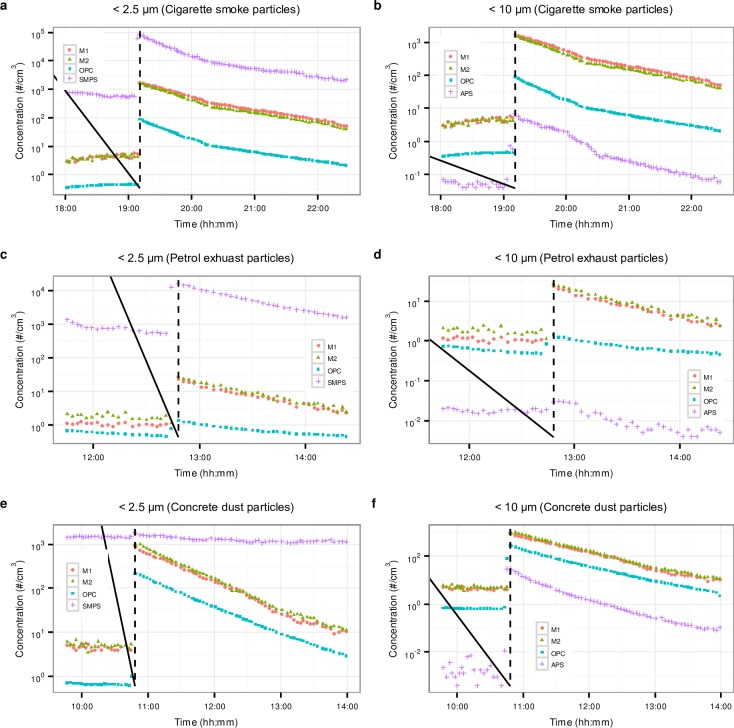
Time series of particles number concentrations measured during the chamber experiments.a) Cigarette smoke particles in the size fraction: M1 ≤ 2.5 μm, M2 ≤ 2.5 μm, OPC ≤ 2.1 μm and SMPS = total PNC. b) Cigarette smoke particles in the size fraction: M1 ≤ 10 μm, M2 ≤ 10, OPC ≤ 7 μm and APS = total PNC. c) Petrol exhaust particles in the size fraction: M1 ≤ 2.5 μm, M2 ≤ 2.5 μm, OPC ≤ 2.1 μm and SMPS = total PNC. d) Petrol exhaust particles in the size fraction: M1 ≤ 10 μm, M2 ≤ 10 μm, OPC ≤ 7 μm and APS = total PNC. e) Concrete dust particles in the size fraction: M1 ≤ 2.5 μm, M2 ≤ 2.5 μm, OPC ≤ 2.1 μm and SMPS = total PNC. f) Concrete dust particles in the size fraction: M1 ≤ 10 μm, M2 ≤ 10 μm, OPC ≤ 7 μm and APS = total PNC. The black dotted vertical lines represent times at which the particles were introduced into the chamber.